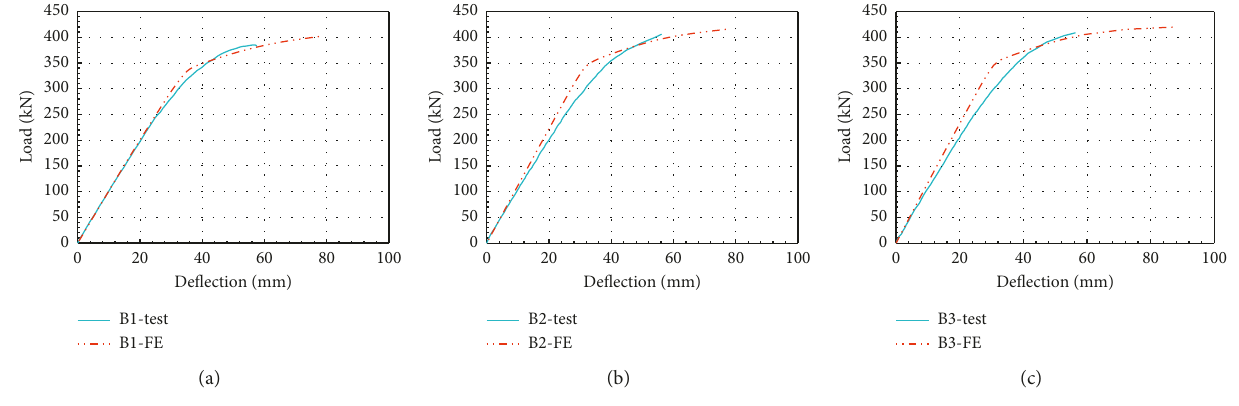
Figure 14: Comparison of the load-deflection curves from the test and FE